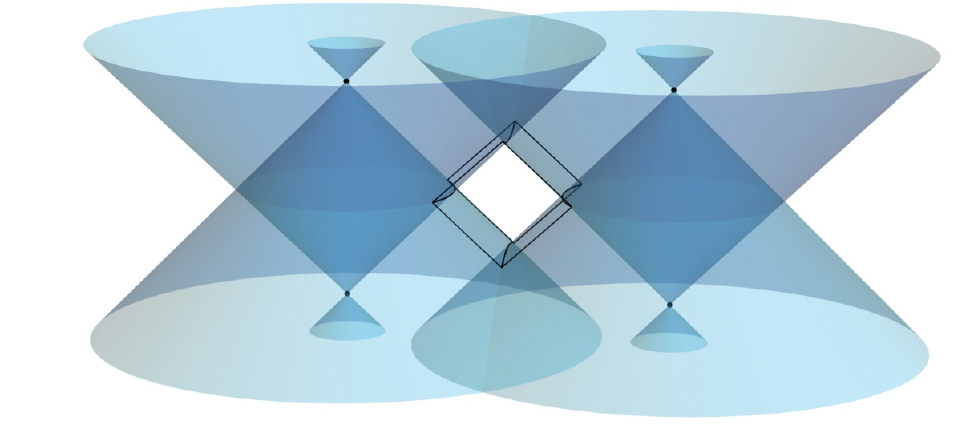
Figure 4 . The region of integration for x 5 is the exterior of the lightcones of the four operators. In the limit of small cross-ratios, the integral is dominated by the region inside the black-outlined box. The width of the box in the transverse directions is large enough to detect the curvature of the lightcones, but small enough not to detect their full